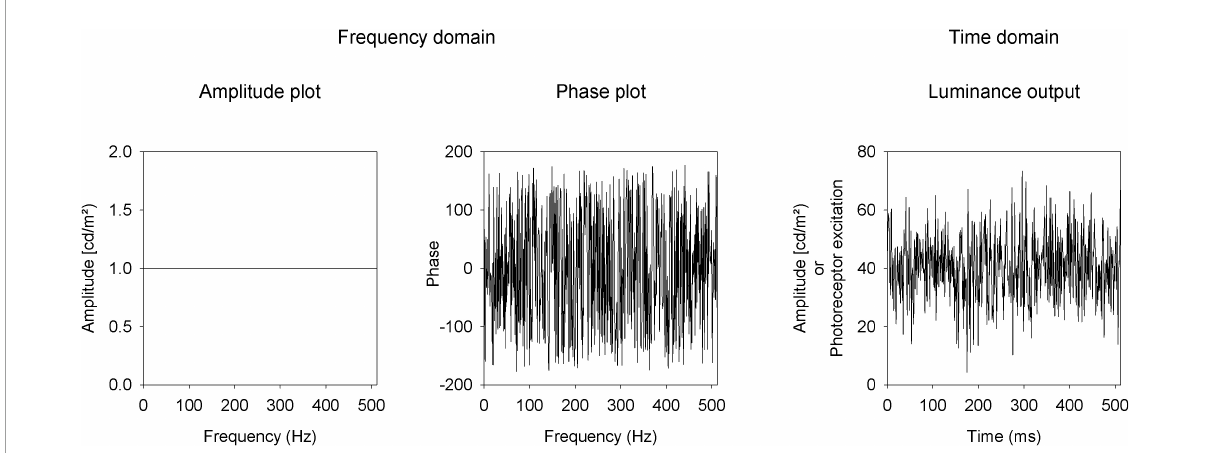
FIGURE1 Description of the temporal white noise stimulus as amplitude (left) and phase (middle) plots in the frequency domain and in the time domain (right) .